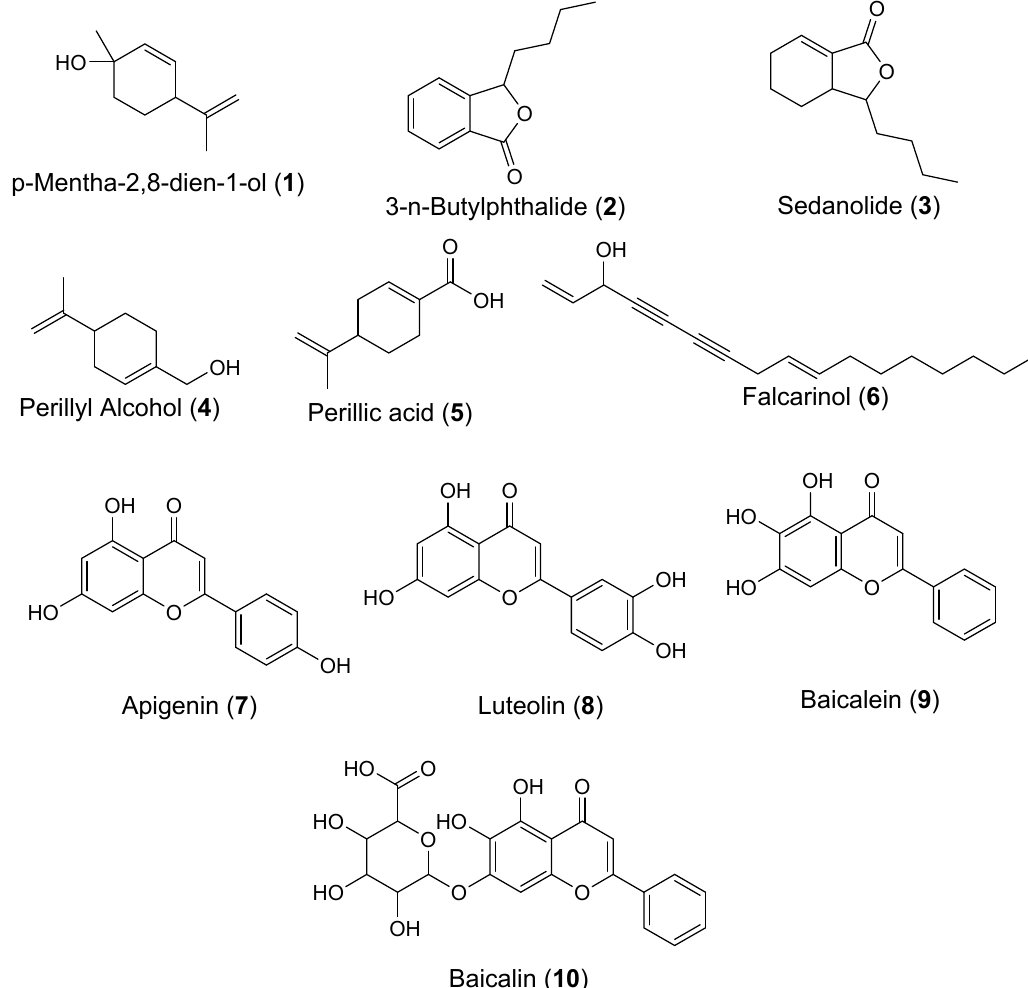
Figure 2. Chemical structure of the most common bioactive ingredients in Apium plants.